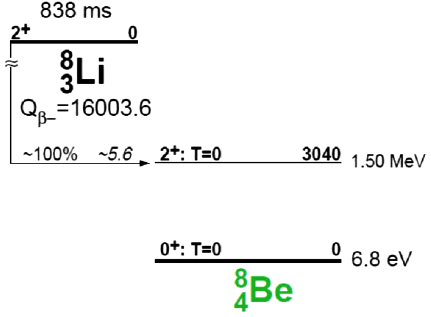
FIG. 10. Partial level scheme of the 8 Li decay. FIG. 11. Time structure used in the